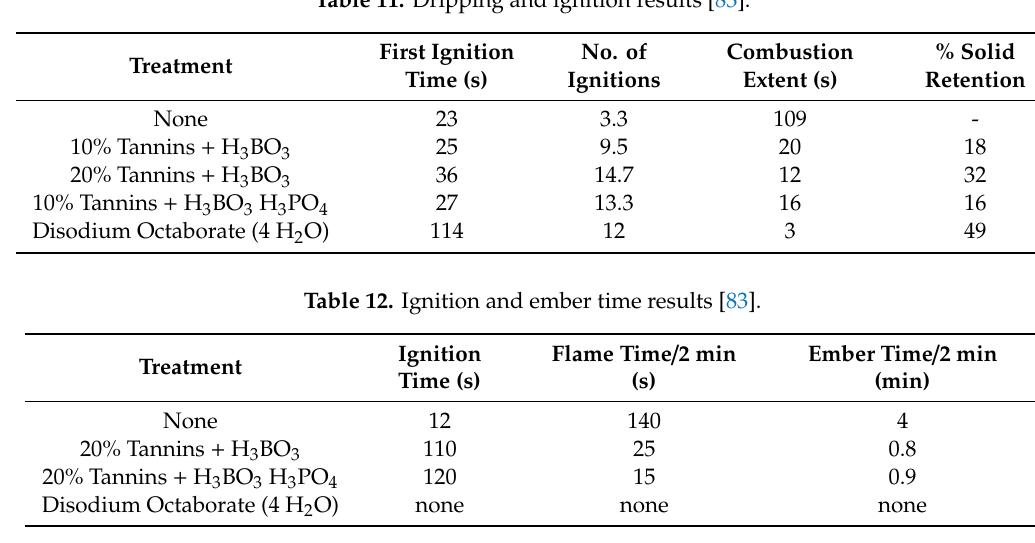
Table 11. Dripping and ignition results [83].